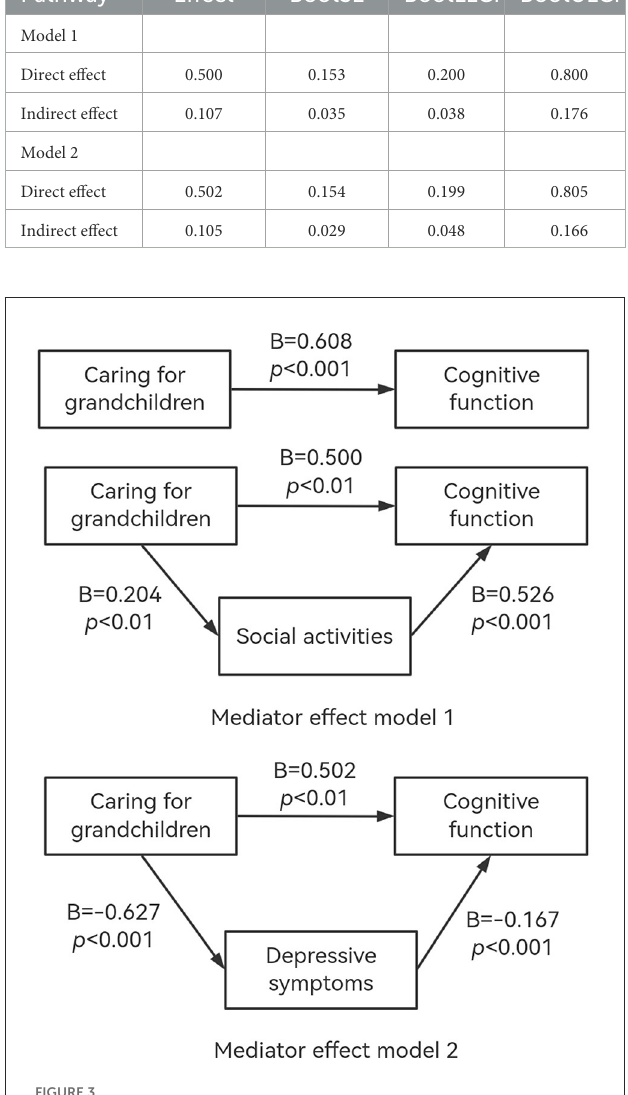
FIGURE3 The conceptional framework of the mediation models. All models were adjusted for age, gender, number of types of chronic diseases, self-reported health status, life